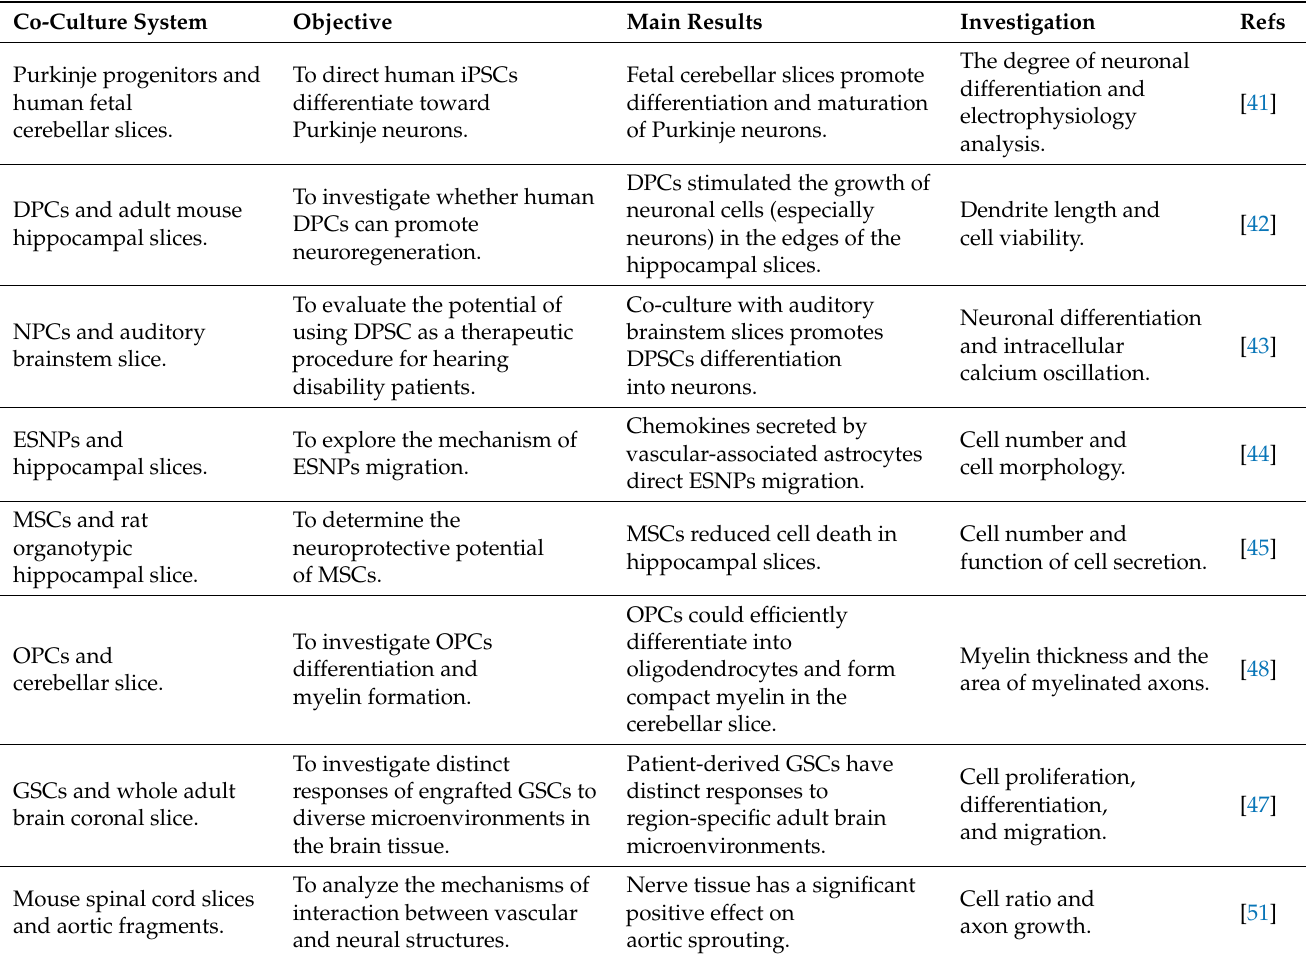
Table 2. Tissue slice-based co-culture